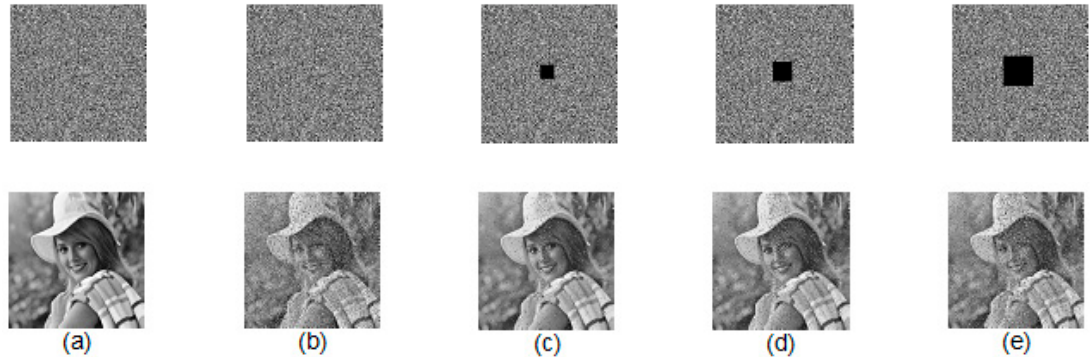
Figure 12. ( a ) Actual cipher image and decrypted image; ( b ) Noisy cipher image with 2% salt and pepper noise and its decrypted image; ( c – e ) Cipher images and their corresponding decrypted images with different percentages of data loss.